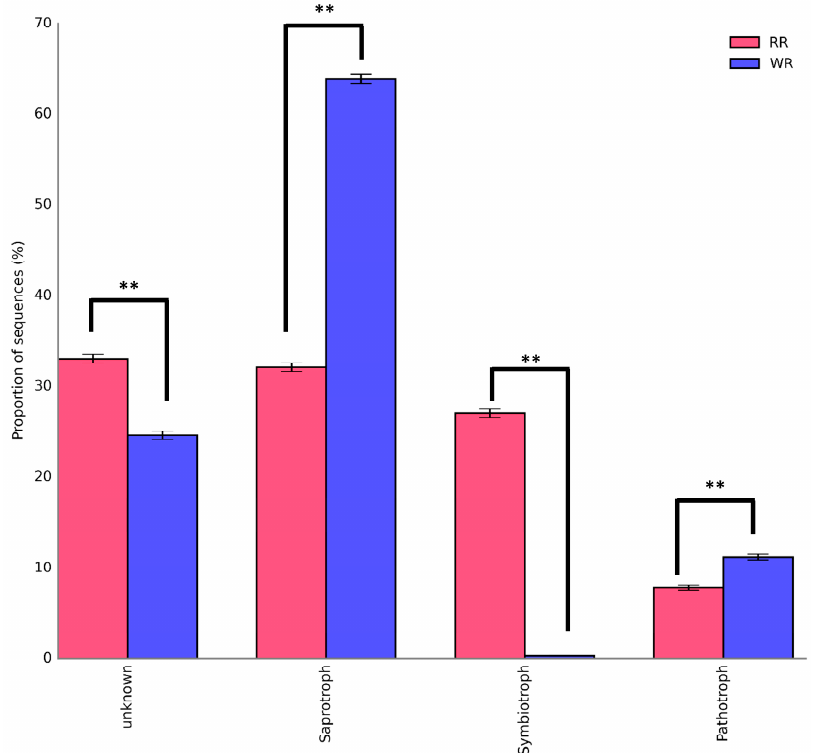
Figure 6. Trophic composition of rhizospheric fungal communities associated with wild and reintroduced M. sinica (rhizospheric soil samples from wild plants (WR, n = 3); rhizospheric soil samples from reintroduced plants (RR, n = 3)). ** P < 0.01.